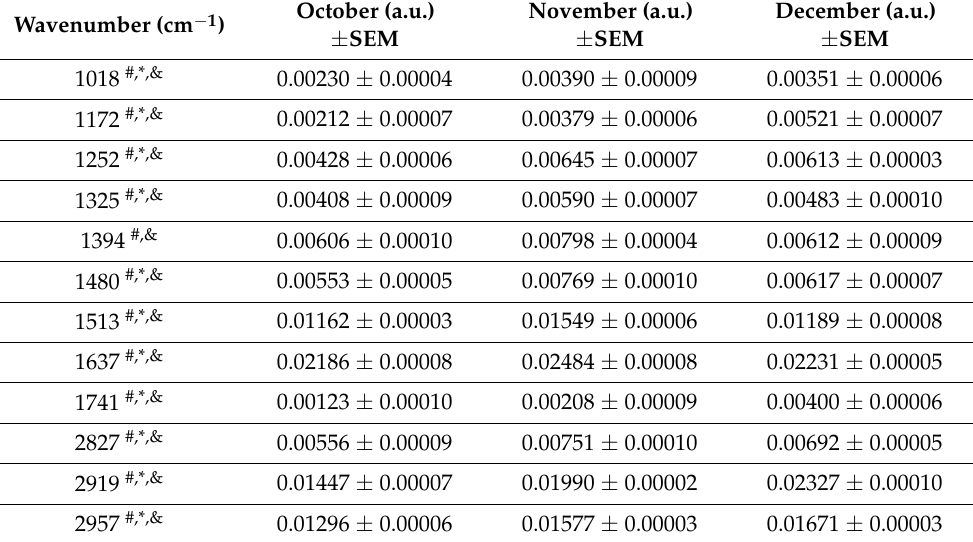
Table 2. Values of maximum absorbance analyzed for the October, November and December types of C. tujafilina . The differences are statistically significant between the October and November ( # ),